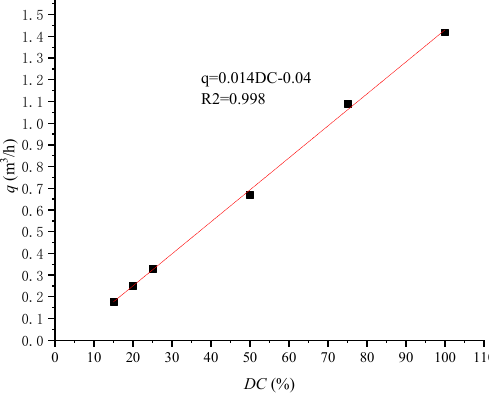
Figure 8. The relationship between the water flow rate and PWM duty ratio. The experimental results showed a linear relationship between the water flow rate and PWM duty cycle. The experimental relationship between the concentrations of the potash fertilizer and compound fertilizer solution and the EC values is illustrated in Table 2. After fitting, an obvious linear relationship between the concentration of the fertilizer solution and the EC value was observed [31]. The relationship between the concentration of the fertilizer solution and the conductivity of the two fertilizers can be further obtained by Equations (18) and